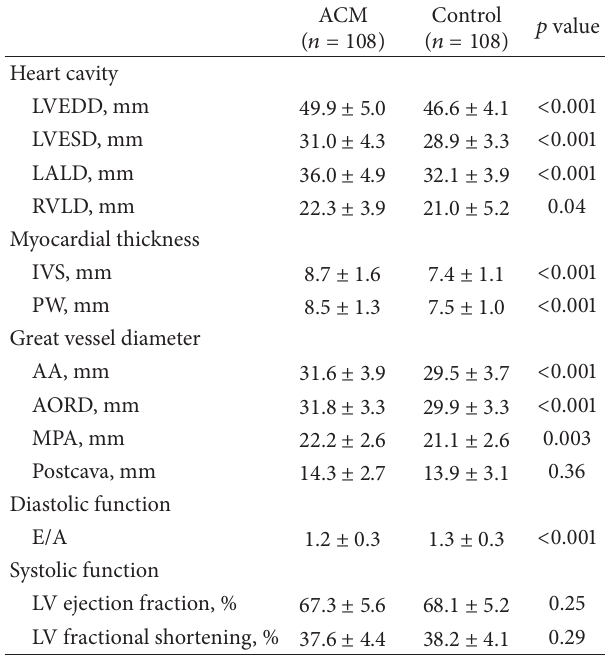
Table 2: Morphological and functional cardiovascular